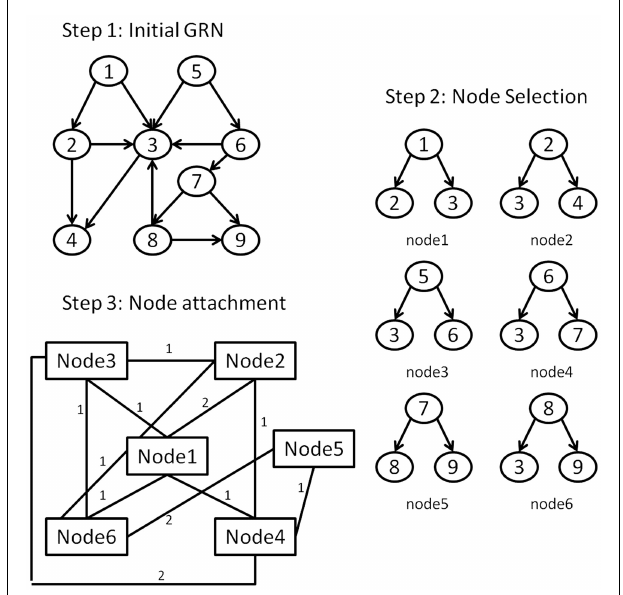
FIGURE 3 | The steps for forming the VMN from a GRN: (Step 1) An initial GRN is considered . (Step 2) A list of the downlink structures is derived from the GRN giving each downlink structure its unique id. (Step 3) Each downlink’s constituent nodes are contrasted with every other downlink’s nodes. Downlinks form topological interactions in the VMN if they have at least one common node. The strength of the interaction is equivalent to the number of shared nodes between the corresponding